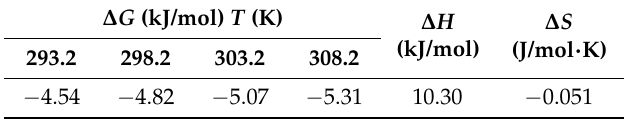
Table 5. Thermodynamics parameters of MIL-101-TEPA@CA for removing